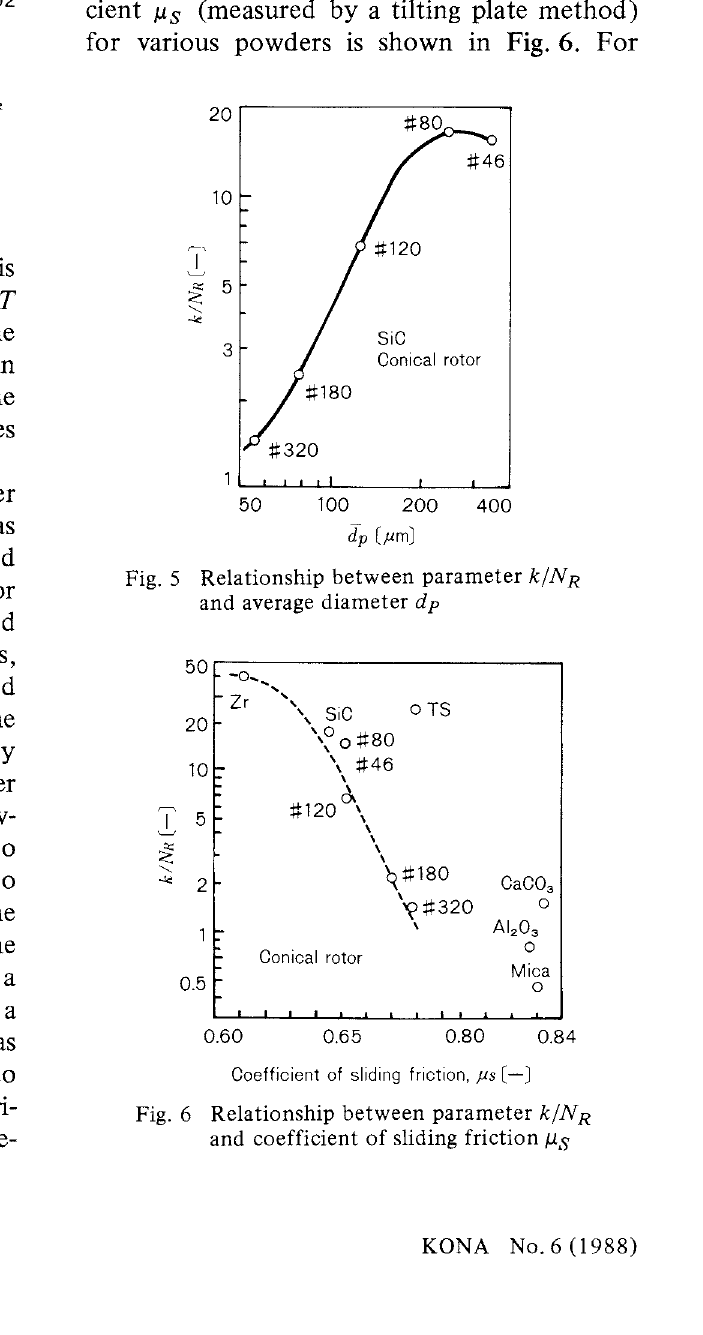
Fig. 6 Relationship between parameter k/N R and coefficient of sliding friction